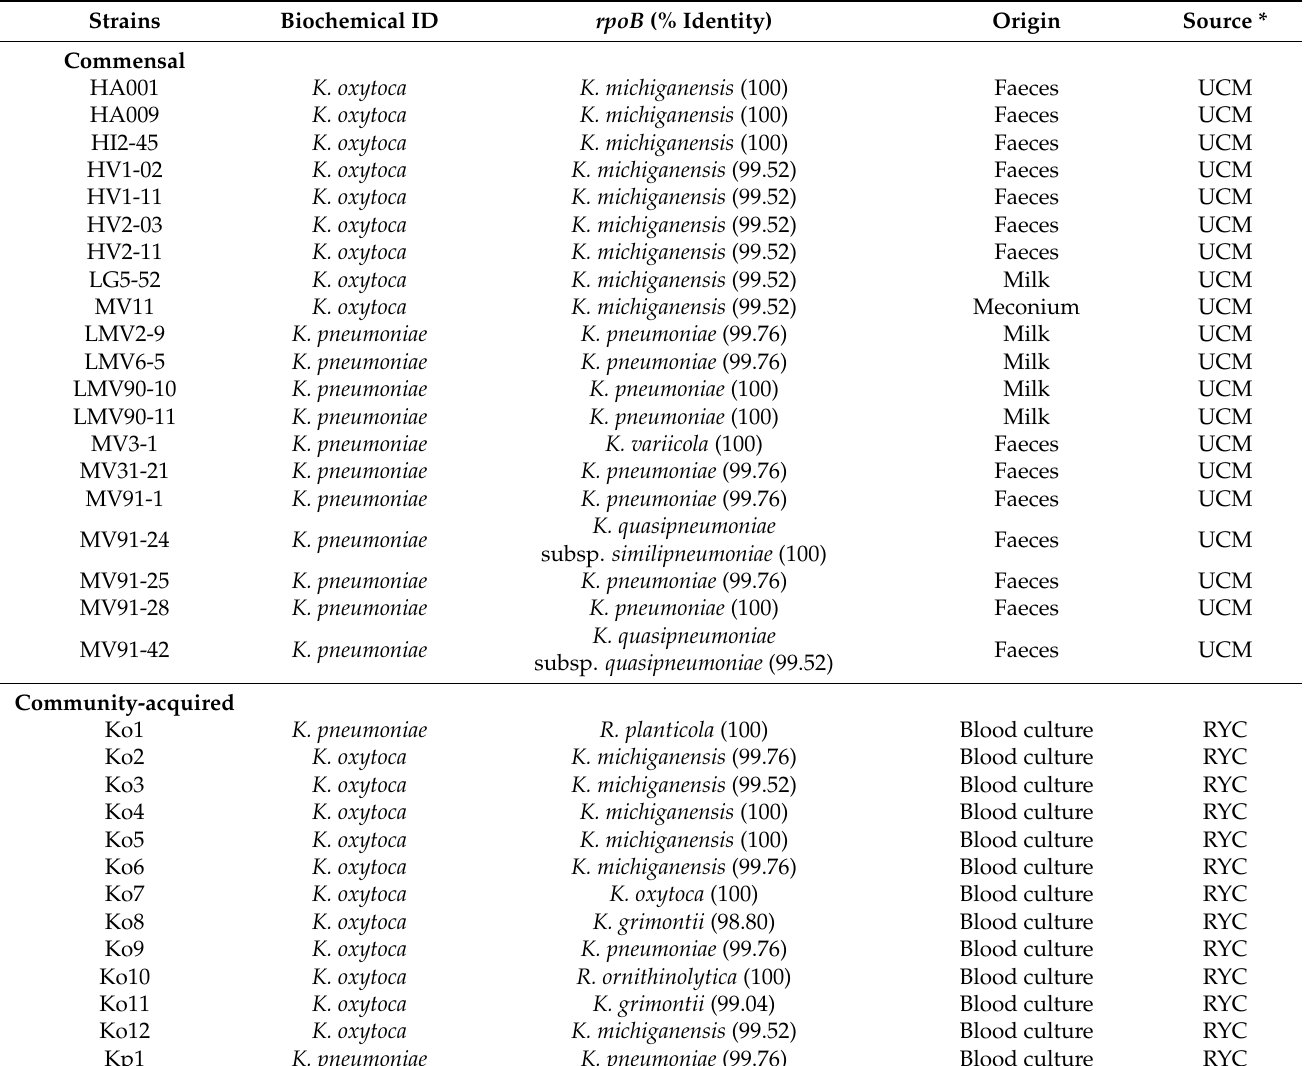
Table 1. Biochemical and molecular identification (based on partial rpoB gene sequencing) of commensal, community- acquired, NICU outbreak and reference strains used in this study.